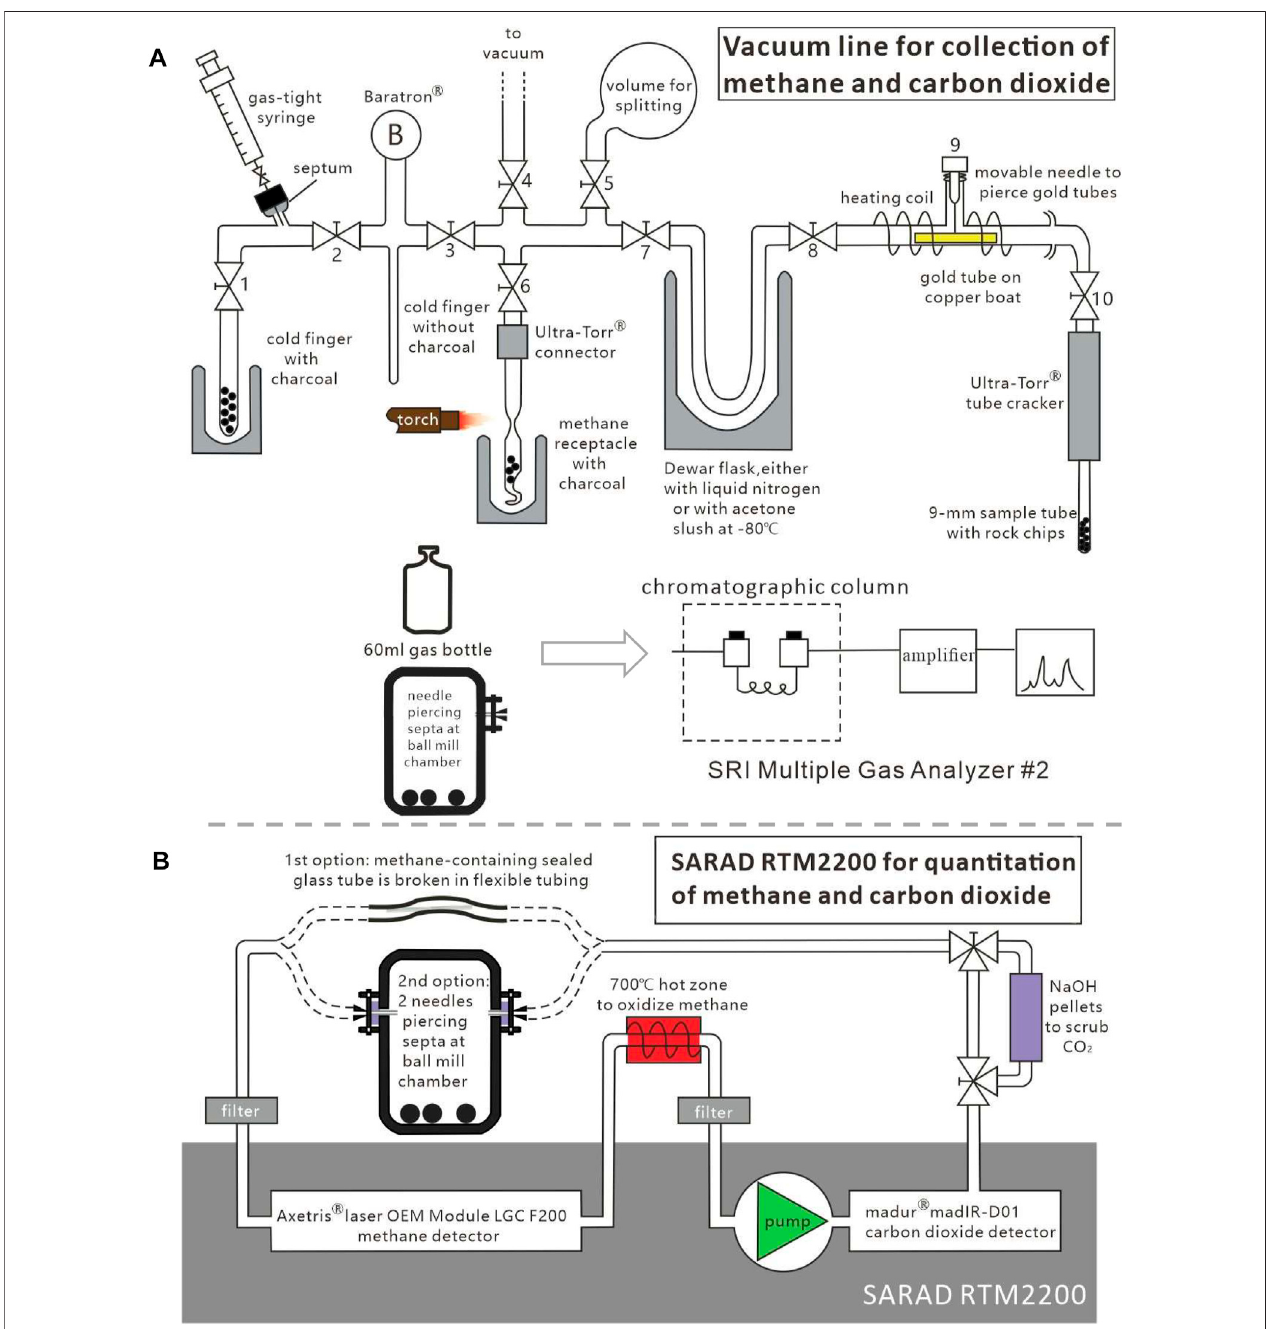
FIGURE 1 | Schematic diagram showing gas collection process. (A) Glass vacuum line for cryogenic collection of gases from glass ampoules after low- temperature heating experiments (modi fi ed from Wei et al., 2018). Collected methane/carbon dioxide gas in the receptacle under valve 6 and gas released from 65 − mL SPEX8000ballmillwereseparatelytransferredusingasyringetoSRImultiplegasanalyzer forquanti fi cation (B) SchematicdiagramofquantitationofCH 4 andCO 2 with a SARAD RTM2200 gas detector system with closed-circuit gas fl ow (modi fi ed from Ma et al., 2021).